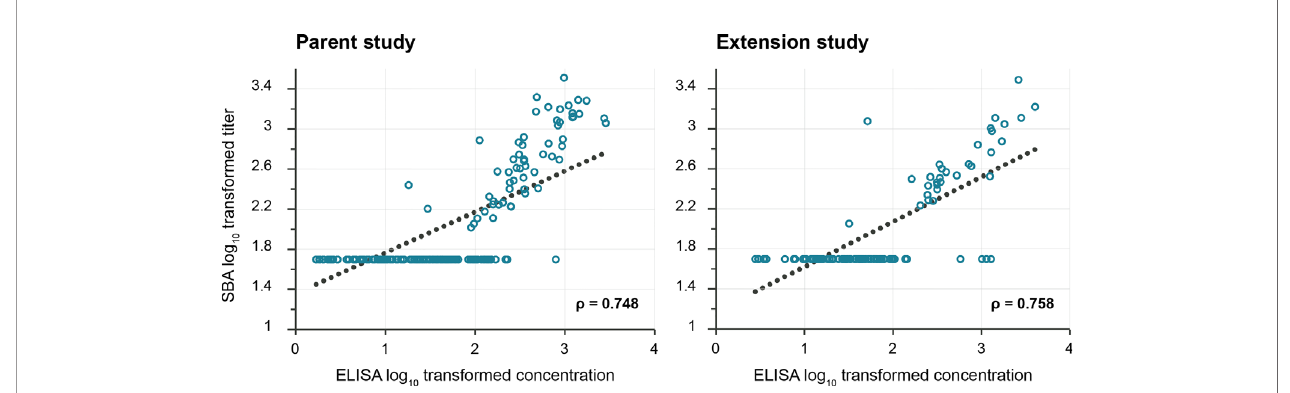
FIGURE 4 | Pearson correlation between anti- S. sonnei LPS serum IgG antibody concentrations and SBA titers. LPS, lipopolysaccharide; IgG, immunoglobulin G; SBA, serum bactericidal activity; ELISA, enzyme-linked immunosorbent assay; EU, ELISA unit. The lower limit of quanti fi cation was 100 (IC50) for SBA and 3.1 – 4.1 EU/mL (parent study) and 5.5 – 7.4 EU/mL (extension study) for ELISA. The p-values were <0.0001 for both coef fi